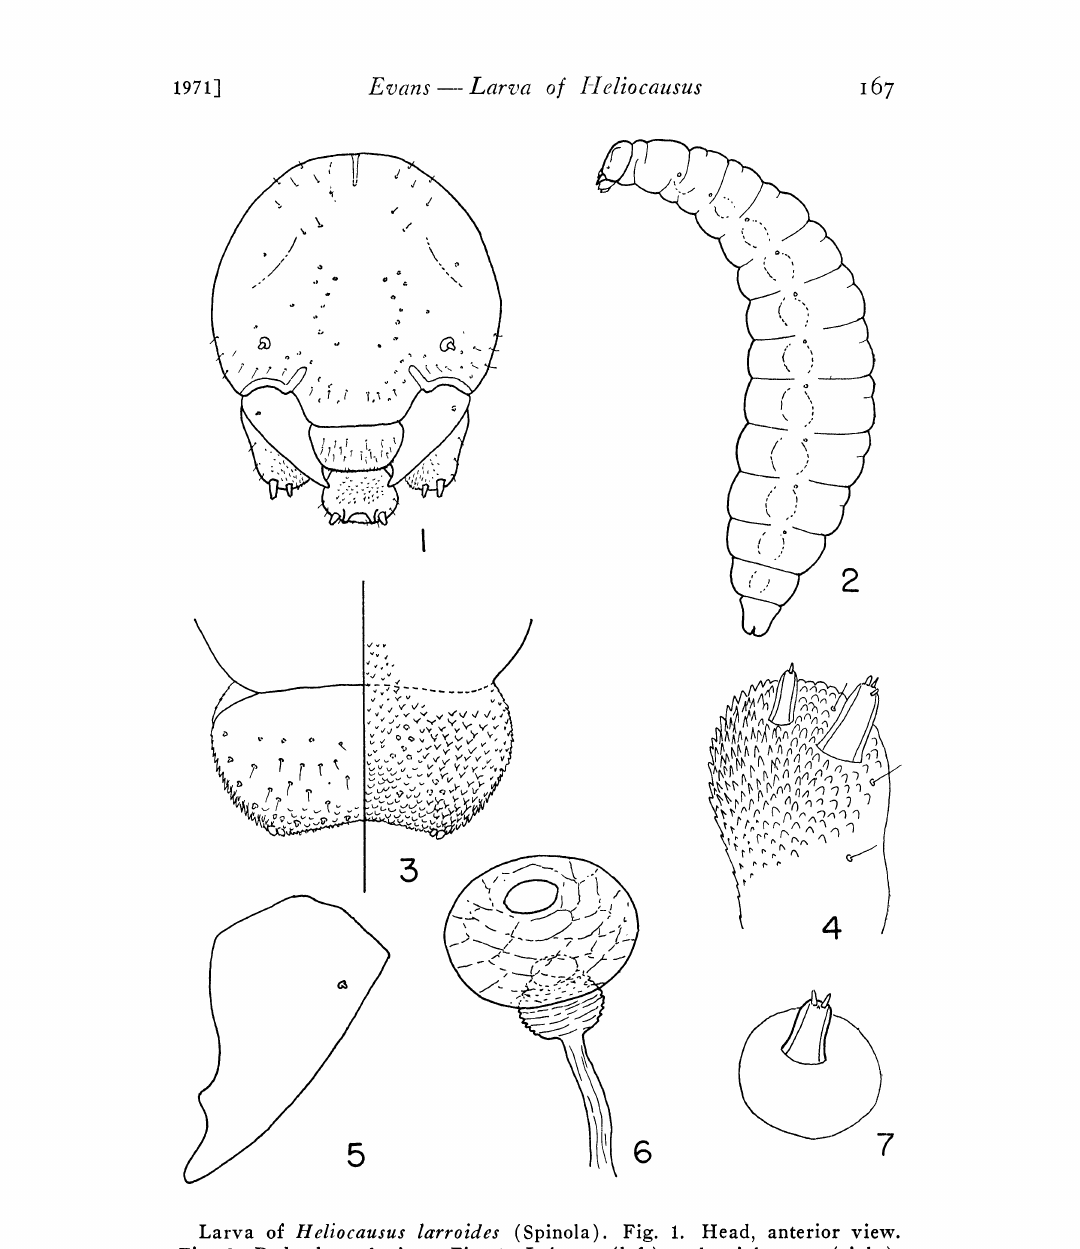
Larva of Heliocausus lctrroides (Spinola). Fig. 1. Head, anterior view. Fig. 2. Body, lateral view. Fig. 3. Labrum (left) and epipharynx (right). Fig. 4. Maxilla. Fig. 5. Mandible. Fig. 6. First thoracic spiracle. Fig. 7. Antennal orbit and